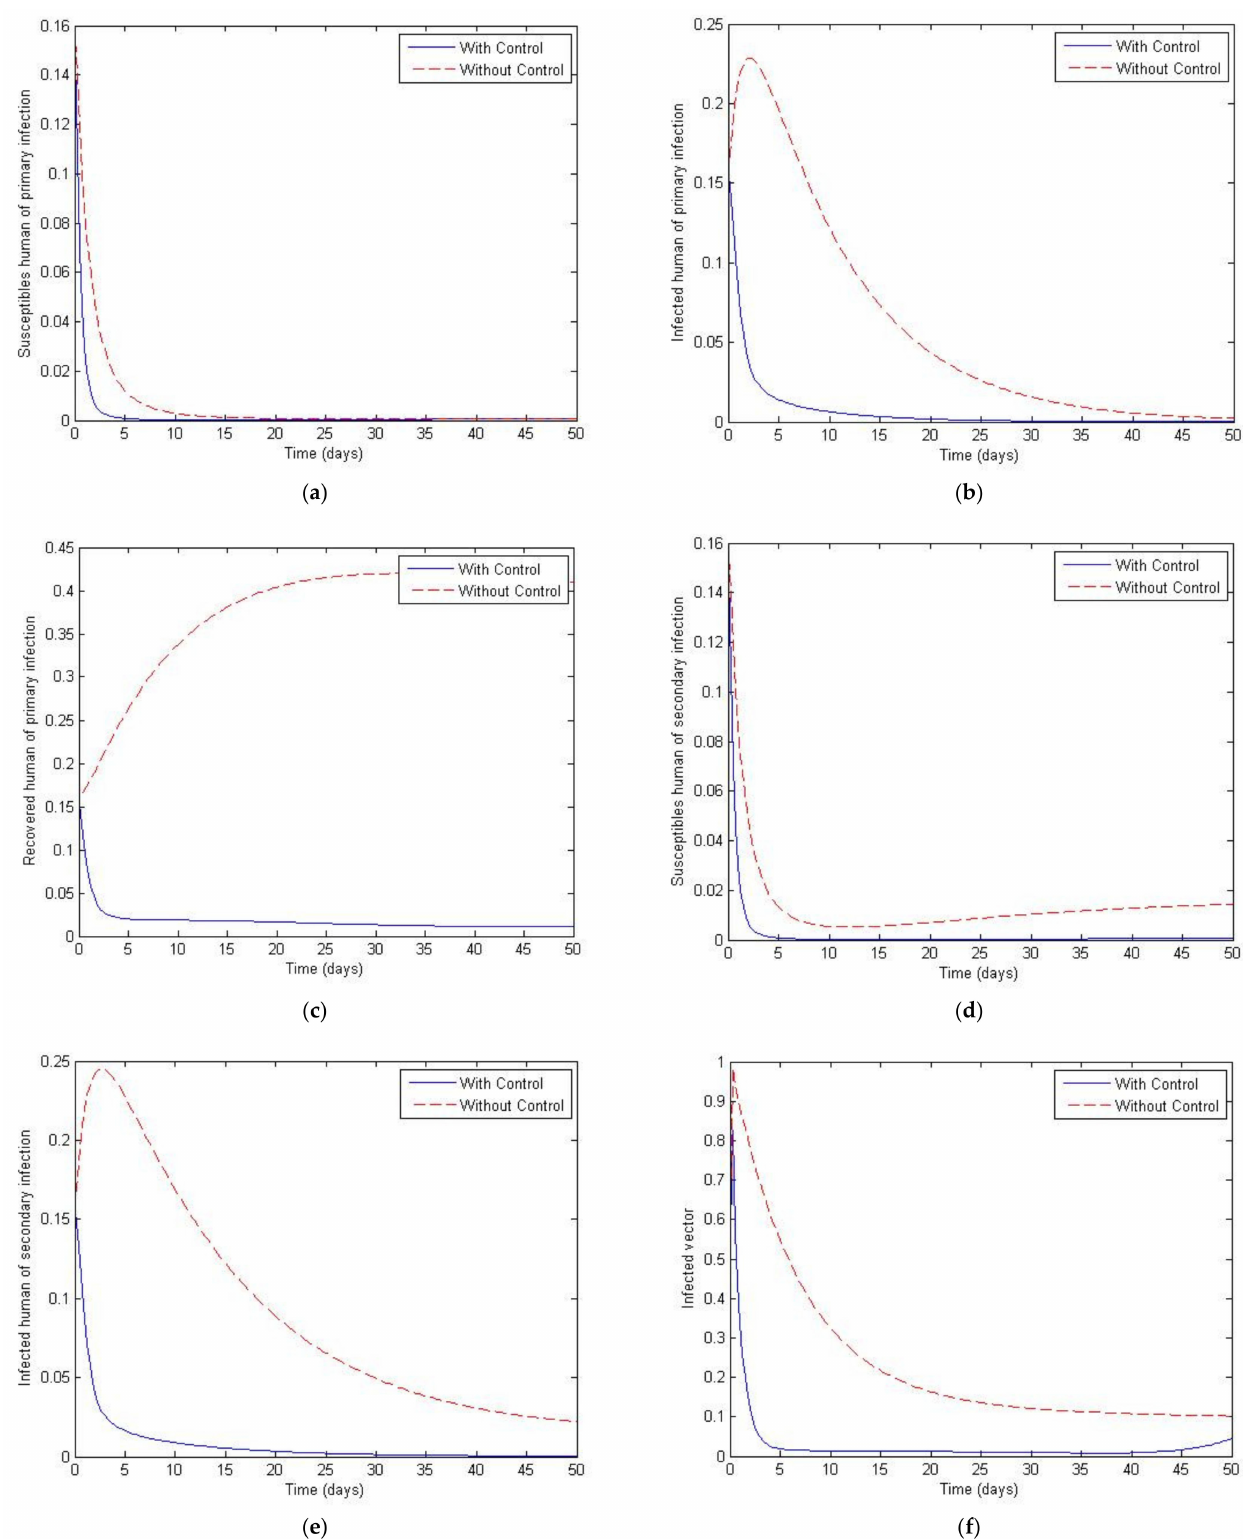
Figure 18. Simulation results of system of Equations (38)–(43) with and without controls of S HP , I HP , R HP , S HS , I HS and I V with X 1 = 100, X 2 = 100, N H = 500,000, N V = 100,000 e ( − 1/14 ) t . ( a ) Susceptibles of primary infection ( b ) Infected population with primary infection ( c ) Recovered human of primary infection ( d ) Susceptibles of secondary infection ( e ) Infected human of secondary infection ( f ) Infected